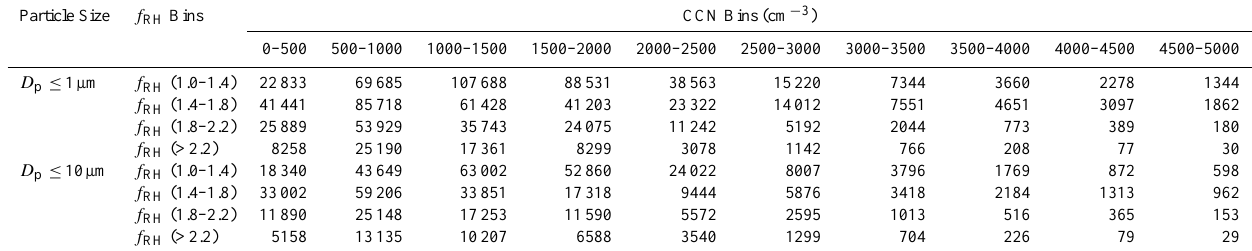
Table 4. Sample size for the data points in Fig. 5a and b. Particle Size f RH Bins